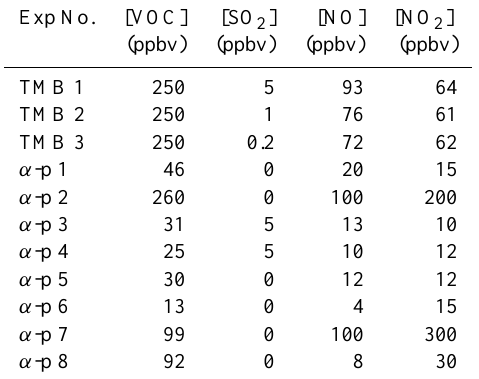
Table 1. Initial gas mixing ratios for 3 TMB and 8 α -pinene exper- iments.